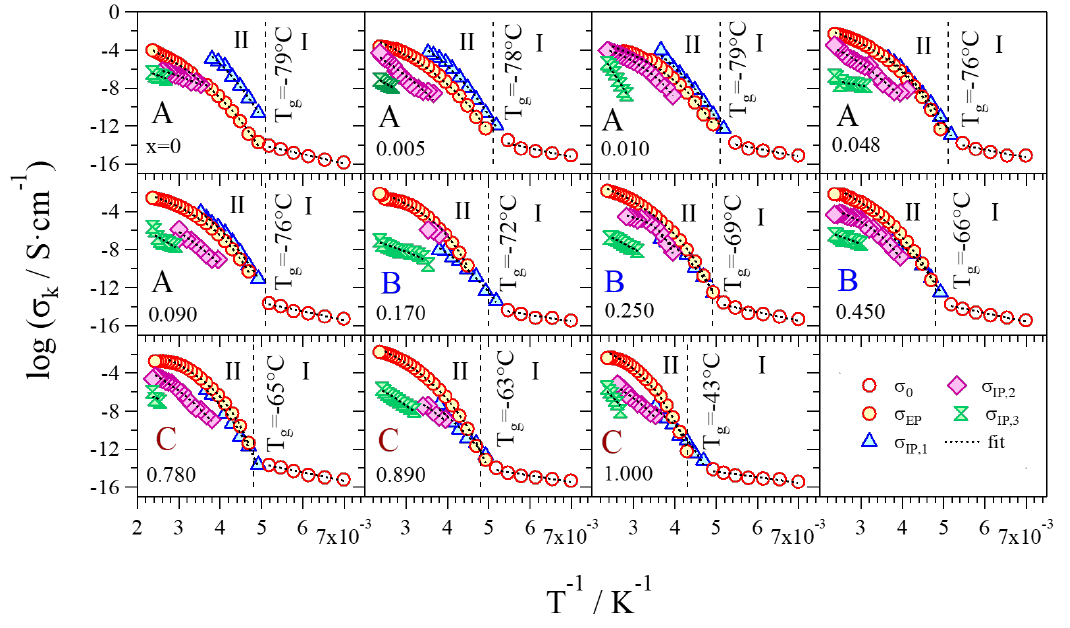
Figure 9. Log σ k vs T −1 curves of each polarization for every sample. Regions I and II are divided by the T g of the sample.